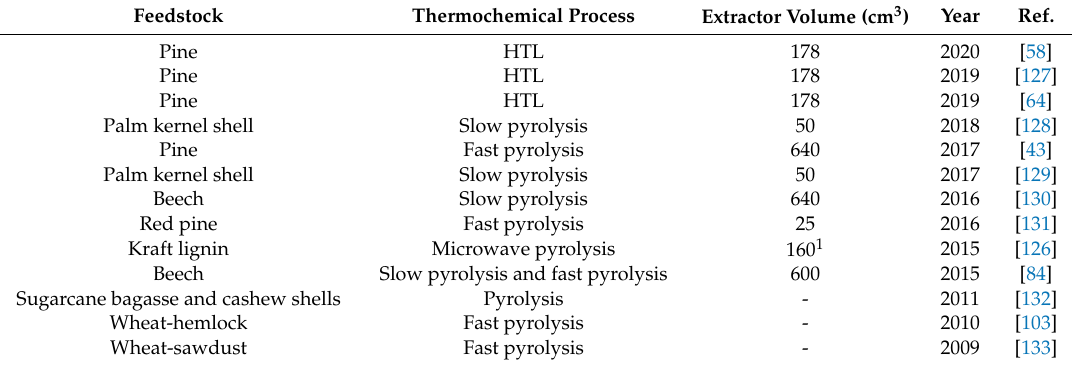
Table 6. Experimental studies of semi-continuous sCO 2 fractionation of